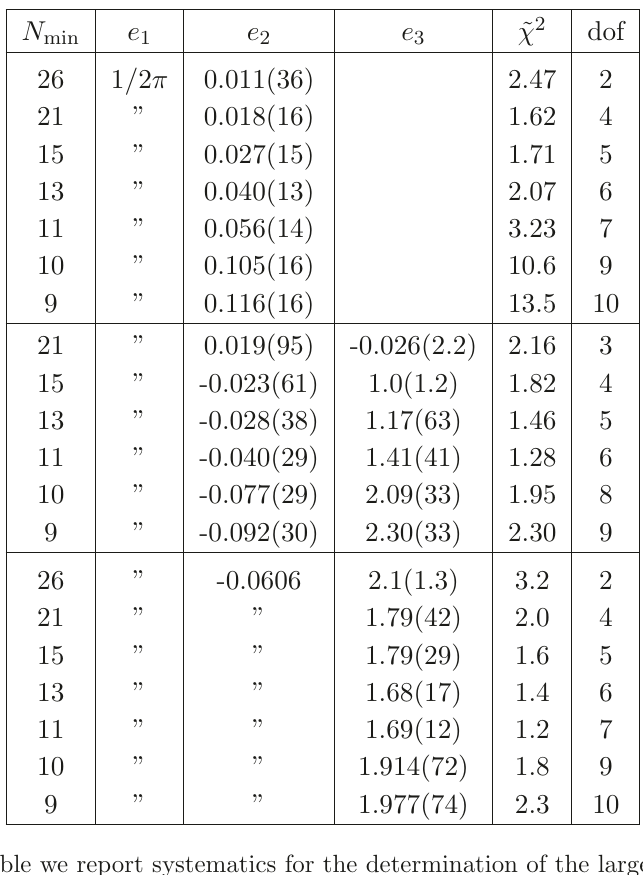
Table 3 . In this table we report systematics for the determination of the large- N behavior of ξ 2 χ using the fit function Nξ 2 χ = e 1 + e 2 /N + e 3 /N 2 . Blank spaces mean that the corresponding coefficient was set to 0 in the fit procedure while numerical values with no error mean that the corresponding coefficient was fixed to that